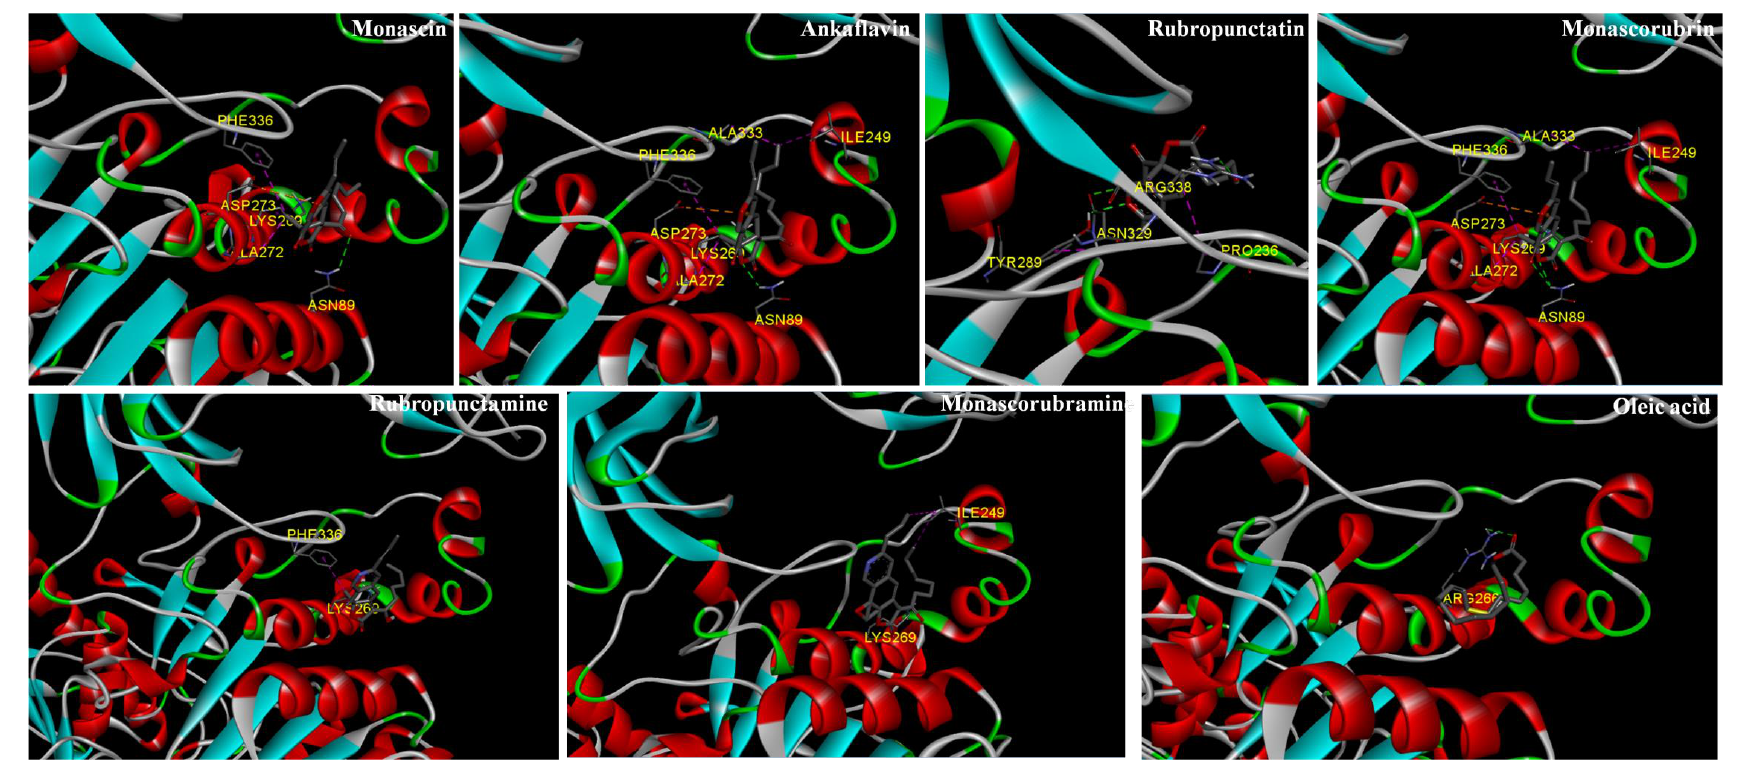
Figure 7. Predicted binding mode of Monascus pigments to lipase (PDB: 1EHT). The best scored docking pose is shown. Green dashed lines are hydrogen bonds, purple dashed lines are hydrophobic interactions, and orange dashed lines are electrostatic bonds.